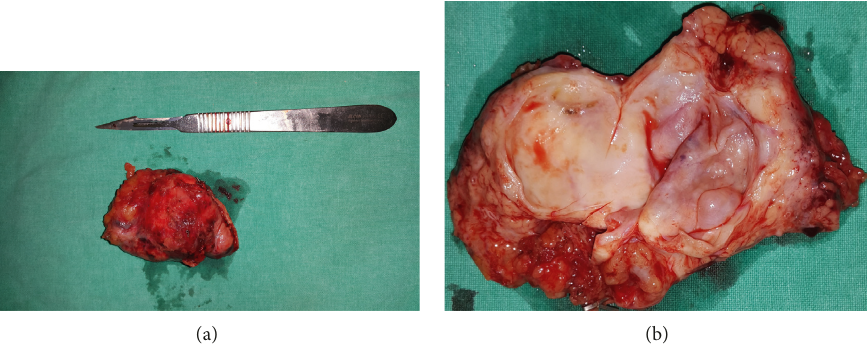
Figure 5: Specimen (a) after extraction and (b) after being divided. The dual cystic lesion is visible.